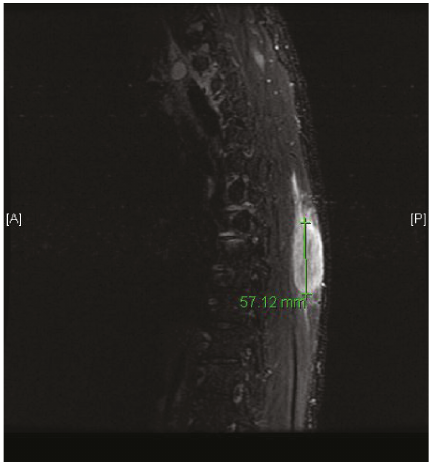
Figure 3: Intramuscular mass well demarcated with MRI imaging.